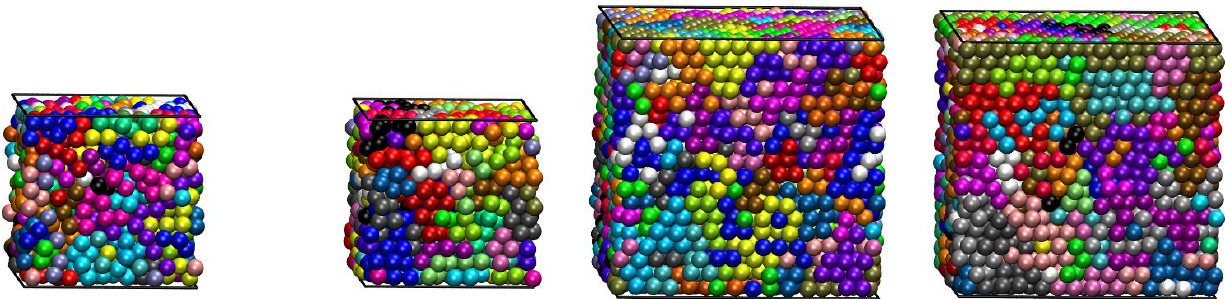
Figure 1. Snapshots of computer-generated configurations at the end of MC simulations. Left to right: 100 chains of N = 12 at ϕ = 0.50; 50 chains of N = 24 at ϕ = 0.54; 96 chains of N = 50 at ϕ = 0.58; and 48 chains of N = 100 and ϕ = 0.61. The sphere monomers are shown, with the coordinates of their centers being subjected to periodic boundary conditions in the y and z dimensions. The spheres are color-coded according to the parent chain. The flat hard walls along the confined ( x ) dimension are indicated by the black squares. The images were created with the VMD software [57] . The figure panels are also available in 3-D, interactive images.